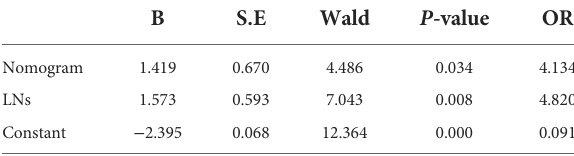
Figure 2C . The AUC, sensitivity, speci fi city, PPV, and NPV of Equation B were 0.798 (95% CI: 0.679, 0.888), 68.2% (95% CI: 45.1%, 86.1%), 83.3% (95% CI: 68.6%, 93.0%), 68.2% (95% CI: 45.1%, 86.1%), and 83.3% (95% CI: 68.6%, 93.0%), respectively. Of note, the AUC of Equation B was signi fi cantly greater than that of the nomogram (0.798 vs. 0.647, P = 0.042) in the validation cohort ( Figure 2C ).